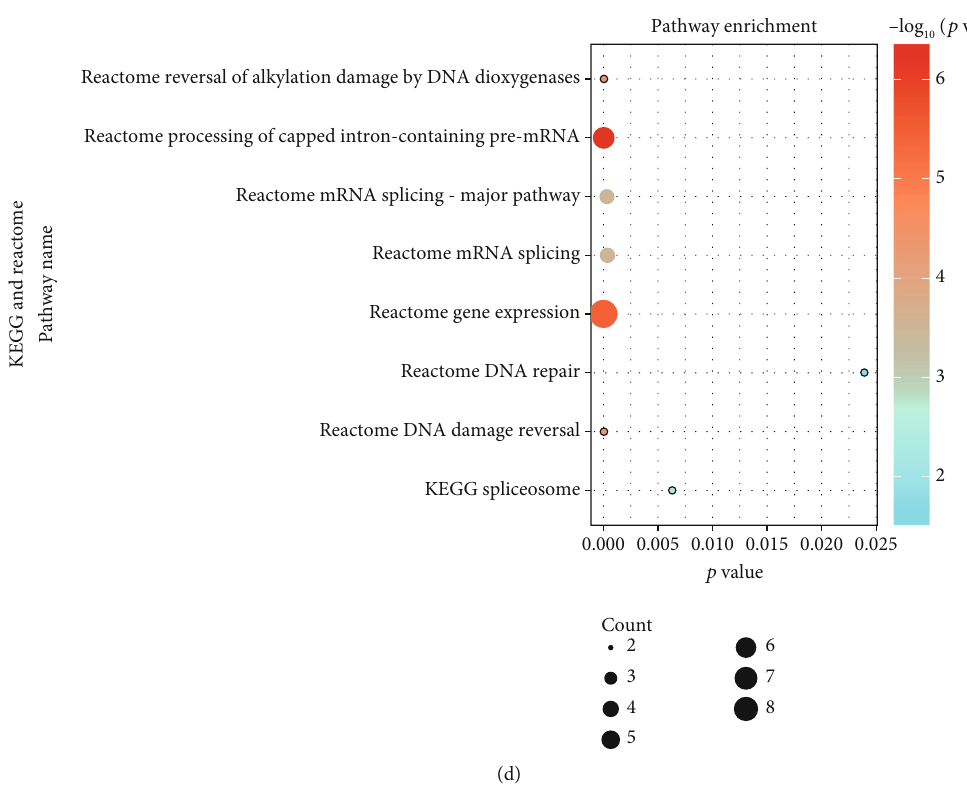
Figure 3: Prognosis and clinicopathological features of ccRCC. (a) The heat map and clinicopathological features of the two clusters were identi fi ed by m 6 A RNA methylation regulators. (b) Kaplan-Meier overall survival (OS) rate curve of patients with ccRCC (cluster 1 patients: red; cluster 2 patients: blue). (c, d) Results from pathway enrichment of the data using Gene Ontology (GO), KEGG, and Reactome. The size of each dot represents the pathway count. High p values are represented by a red-colored dot: the highest the value, the darker the red tone. In contrast, low p values are represented by a blue-colored dot, being the lowest values the darker ones. ∗ p < 0 : 05 , ∗∗ p < 0 : 01 , and ∗∗∗ p < 0 : 001